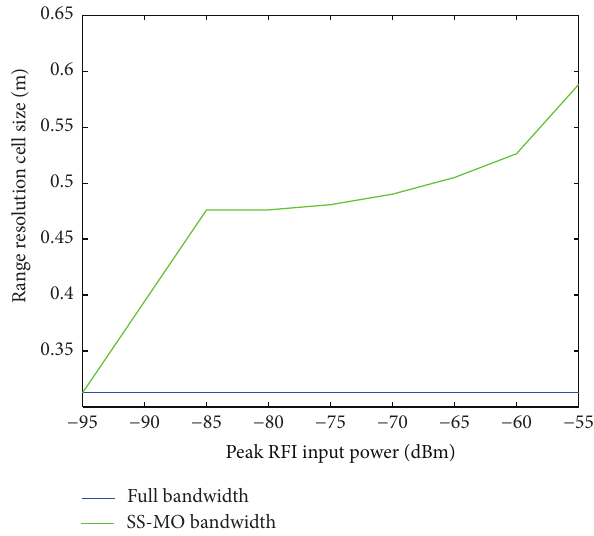
Figure 10: The range resolution cell size results for the narrowband RFI experiment. As is shown, the range resolution cell size is increased when using the SS-MO technique but is within the maximumcellsizeboundaryconditionspecifiedby 𝑍2 max = 3.33